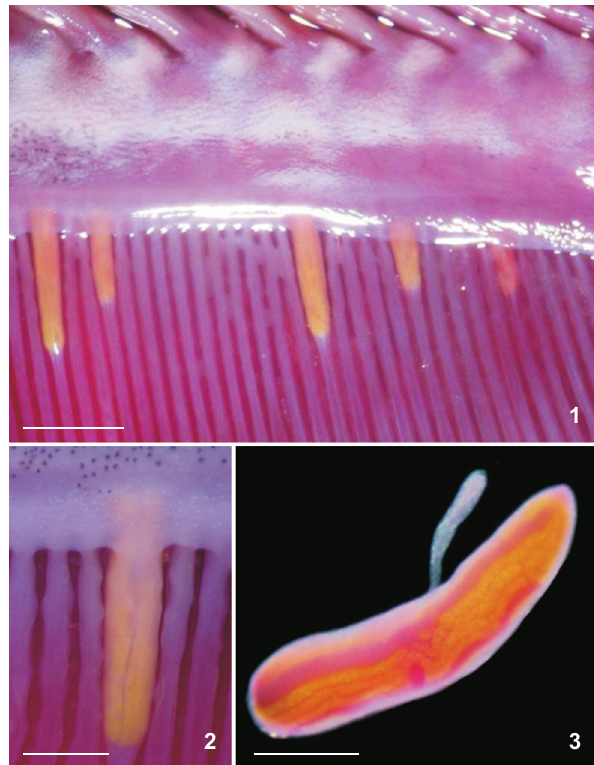
Figures 1-3. Photomicrographies of Didymocylindrus simplex : (1) gill lamellae of Katsuwonus pelamis infected with D. simplex ; (2) cyst of D. simplex with two worms; (3) total. Scale bars 1 = 3 mm, 2-3 = 1 mm.